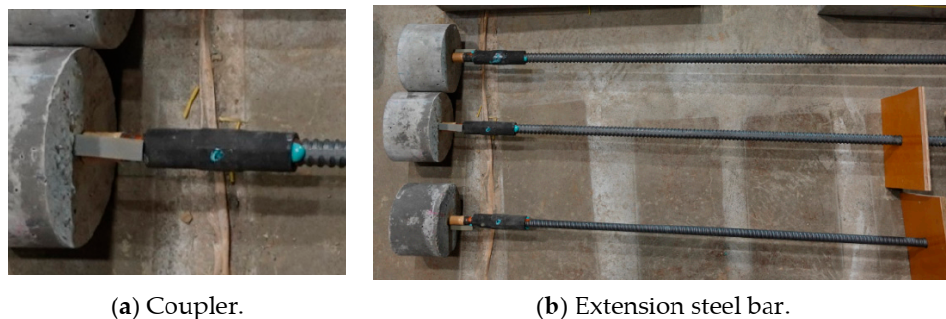
Figure 5. Pullout testing for series IV